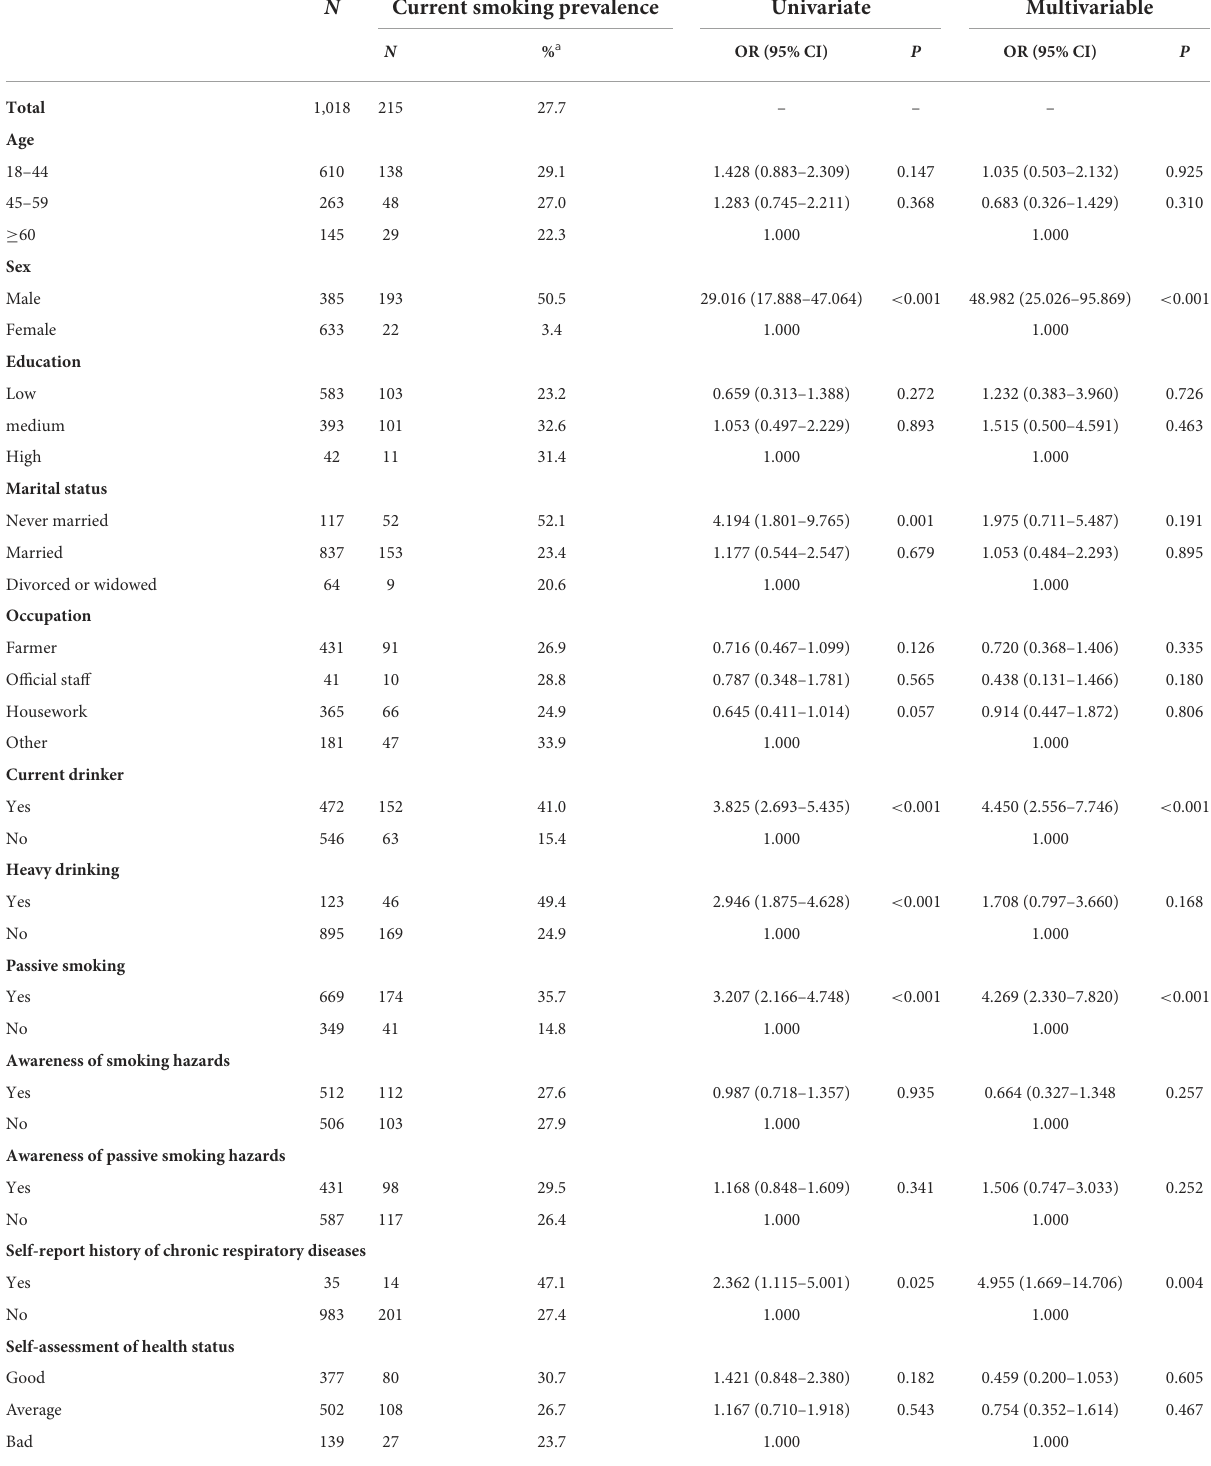
TABLE 4 Prevalence and correlates of current smoking among the